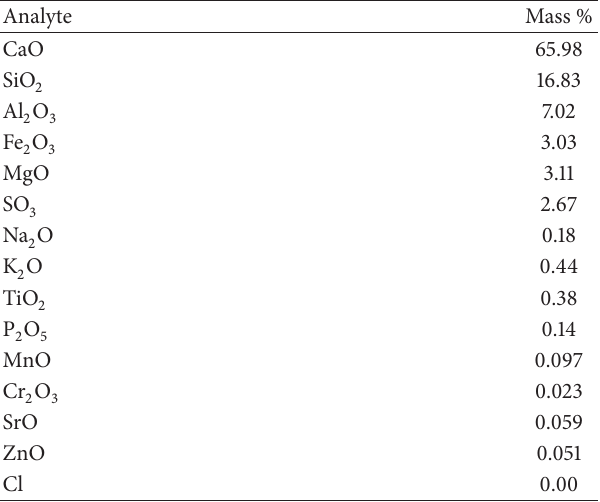
Table 1: Mass % of different elements in OPC cement sample.